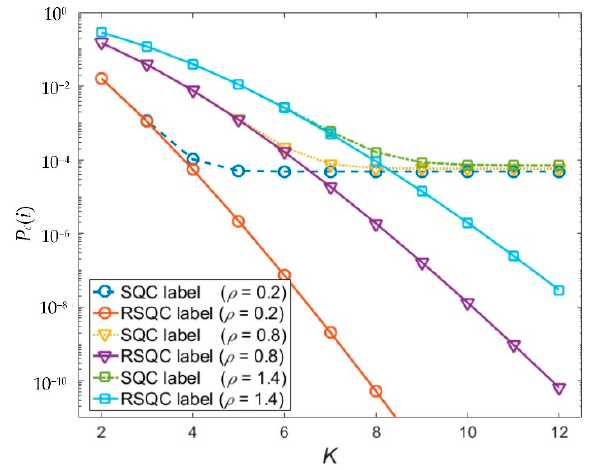
Figure 5. Functions from the assigned code number to code-error rate.